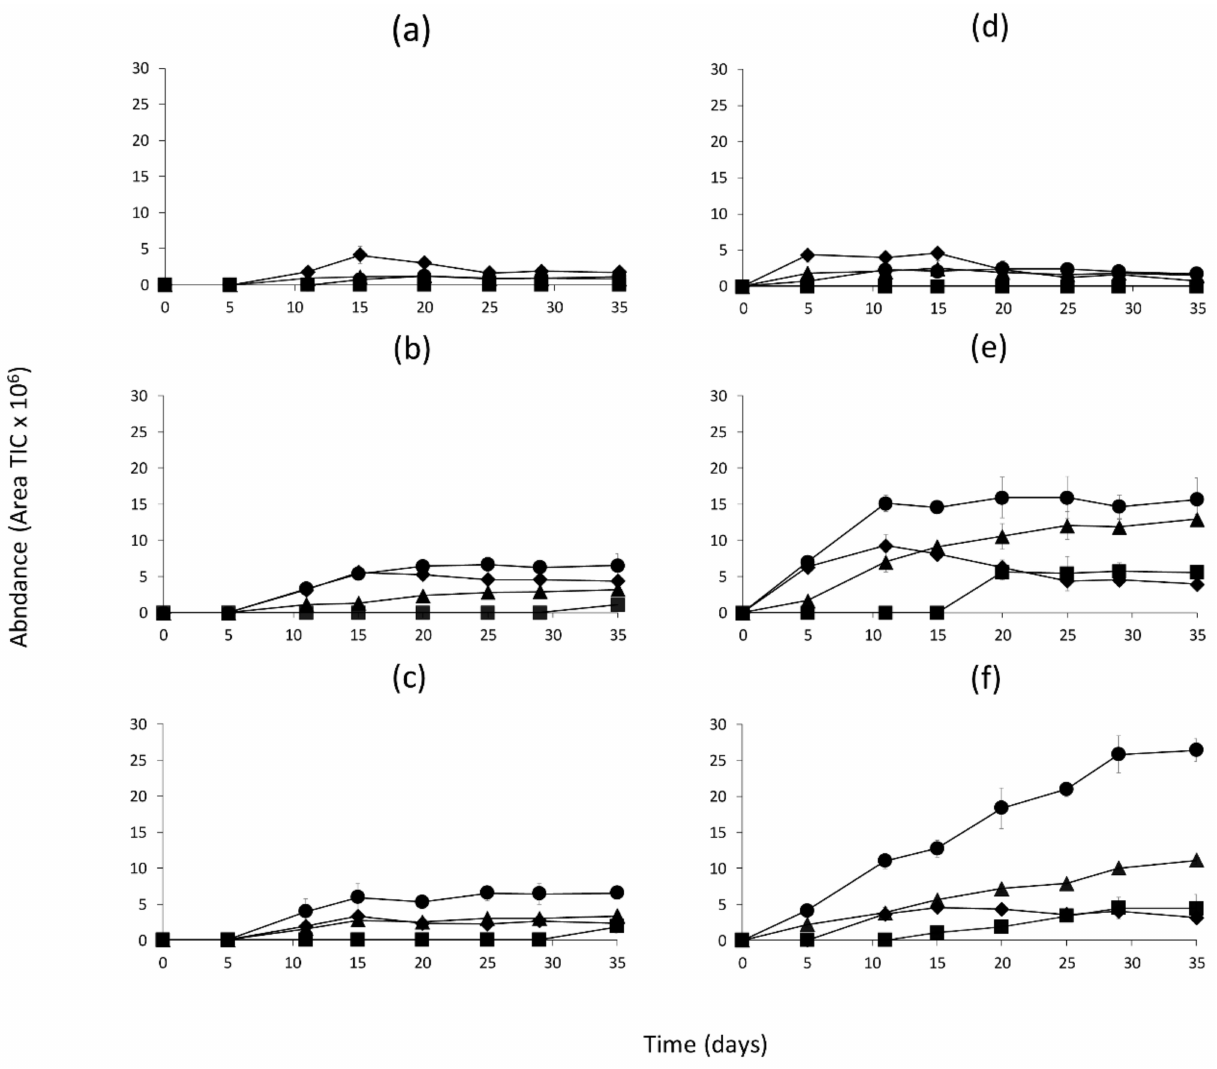
Figure 2. Abundance of volatile compounds derived from sulfur amino acids and Phe in the model systems during incubation at 25 or 37 ◦ C and classified according to the dry curing stages (I-Initial stage, 1D-1st drying stage, 2D-2nd drying stage). ( a ) I-25 ◦ C, ( b ) 1D-25 ◦ C, ( c ) 2D-25 ◦ C, ( d ) I-37 ◦ C, ( e ) 1D-37 ◦ C, ( f ) 2D-37 ◦ C. Symbols represent the different compounds: Dimethyl disulfide ( (cid:4) ); 3-(Methylthio)propanal ( (cid:7) ); Benzaldehyde ( (cid:78) ); Benzeneacetaldehyde ( •